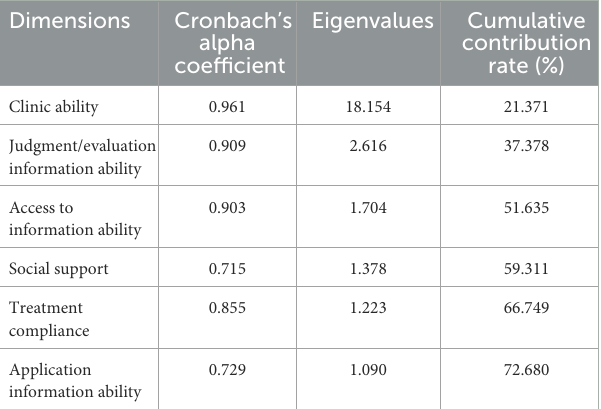
TABLE 5 Cronbach’s alpha coefficient for SSc health literacy